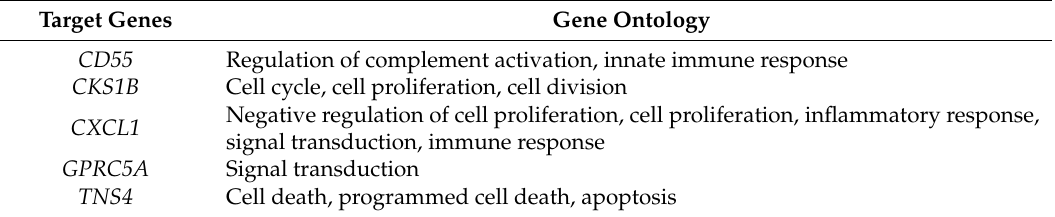
Table 4. Gene ontology of selected target genes of